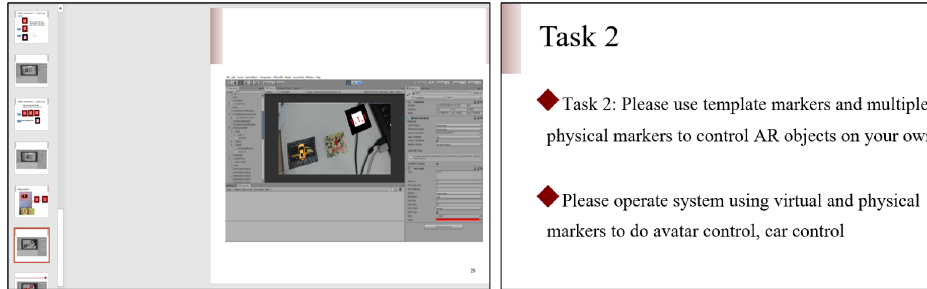
Figure 15. Experimenter scene. Users can freely view the video, text, and picture tutorial on the external screen. This picture shows the video tutorial and task 2 displayed on the external screen. As in task 1, the experimenters’ experiment was performed on the PC screen. Task 2: Please use template markers and physical markers to control car movement and avatar action on your own.